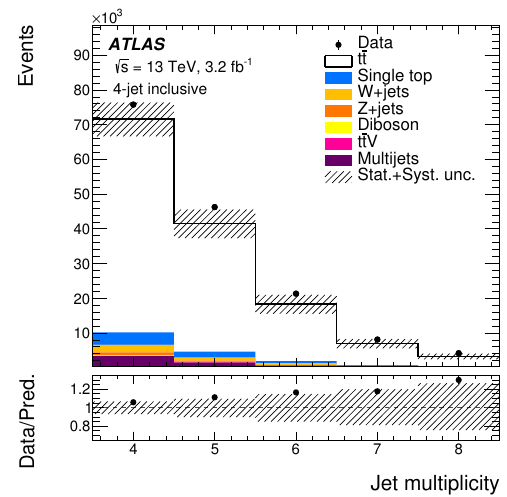
Figure 3 . Distribution of the jet multiplicity in the 4-jet inclusive con(cid:12)guration. Data are com- pared to the sum of signal and background predictions using the nominal sample as the t (cid:22) t signal model. The hatched area indicates the combined statistical and systematic uncertainties in the total prediction, excluding systematic uncertainties related to the modelling of the t (cid:22) t production. Events beyond the range of the horizontal axis are included in the last